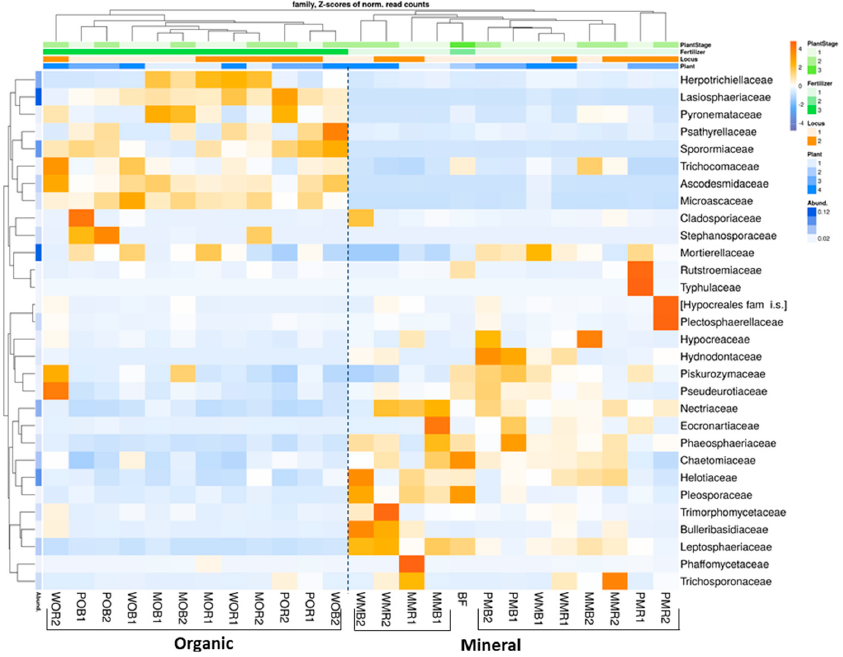
Figure 3. Relative abundances of top 30 fungal taxa in total (DNA) fungal communities of the considered treatments at the family level ( N = 3). The data are given as Z-scores. Abundances of fungal classes with positive Z-scores are marked with orange color, abundances with negative z-scores are marked with blue color. All soil samples are indexed according to the scheme: plant–fertilizer system–soil niche–sampling period. The following indices were used for (I) the crop species: P— po-